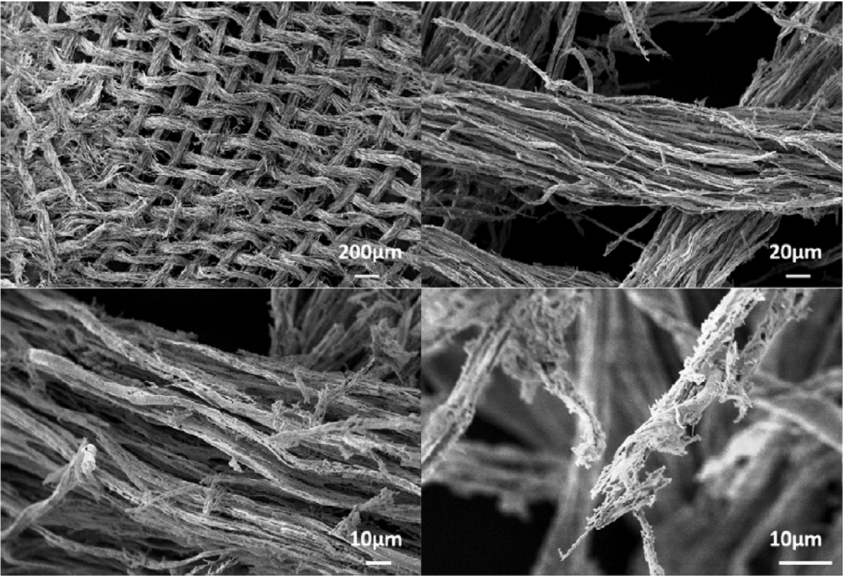
Figure 5. SEM of whey-protein-treated cotton [40].